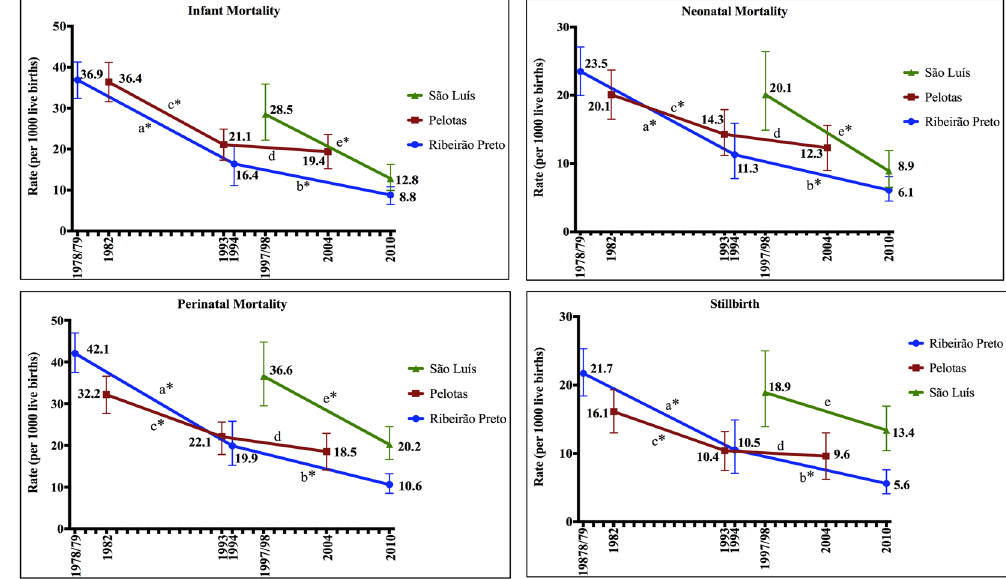
Figure 2. Changes in infant, neonatal, perinatal and stillbirth rates in Ribeirão Preto (1978/79, 1994 and 2010), Pelotas (1982, 1993 and 2004) and São Lui ́ s (1997/98 and 2010). * Indicates that the comparison of the mortality rate during the period showed a p < 0.05 value. ( a ) Comparison between the years 1978/79 and 1994; ( b ) Comparison between the years 1994 and 2010; ( c ) Comparison between the years 1982 and1993; ( d ) Comparison between the years 1993 and 2004; ( e) Comparison between the years 1997/98 and 2010.